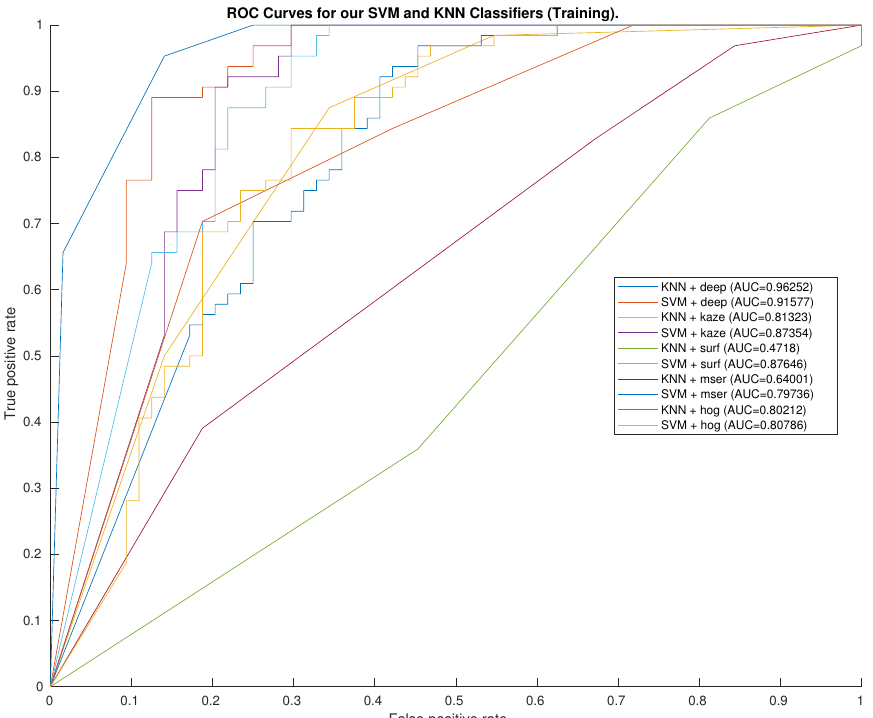
Figure 7. The Receiver Operating Characteristic curves for the proposed method and the evaluation methods on the training data set. The legend in the figure shows the respective Area Under the Curve for each method.